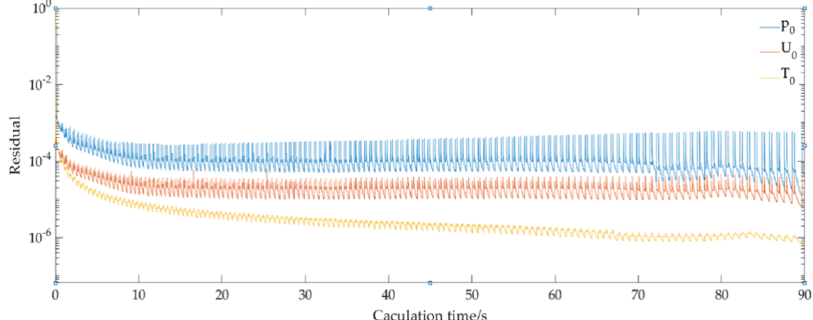
Figure 4. Monitoring residual error curves of pressure, velocity and temperature in the